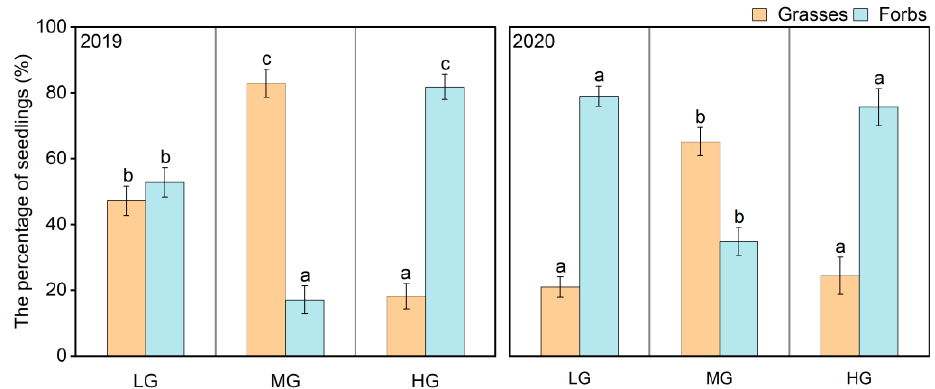
Figure 4. Functional composition percentage of the seedling bank under the different grazing intensities during the two years. Mean ± SE. Different letters indicate significant differences ( p < 0.05) among the different grazing intensities in the same functional groups.